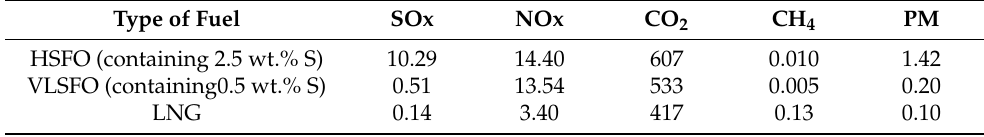
Table 9. Comparison of emission coefficients (g/kWh) of various pollutants from burning different fuels. Type of Fuel SOx NOx CO 2 CH 4 PM HSFO (containing 2.5 wt.% S) 10.29 14.40 607 0.010 1.42 VLSFO (containing0.5 wt.% S) 0.51 13.54 533 0.005 0.20 LNG 0.14 3.40 417 0.13